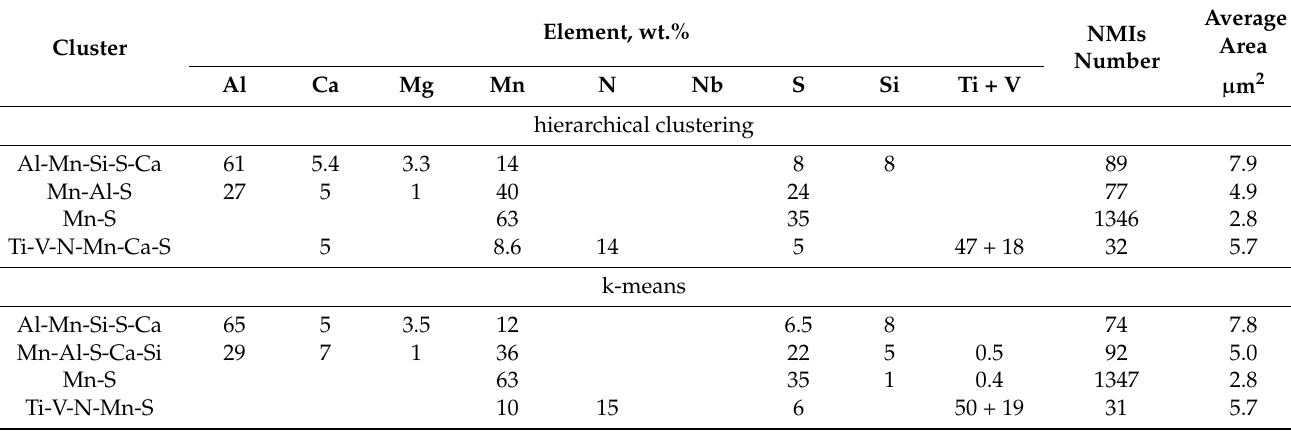
Table A1. Results of clustering by different methods in steel B.